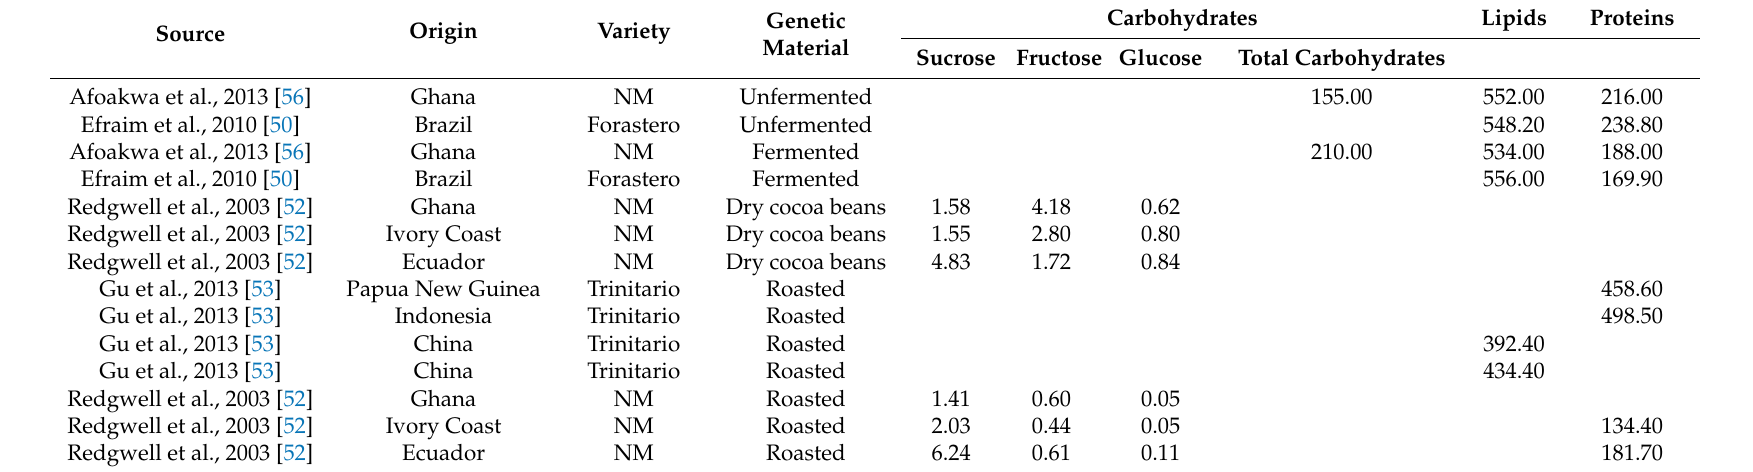
Table 2. Nutritional composition of cocoa beans expressed as g /